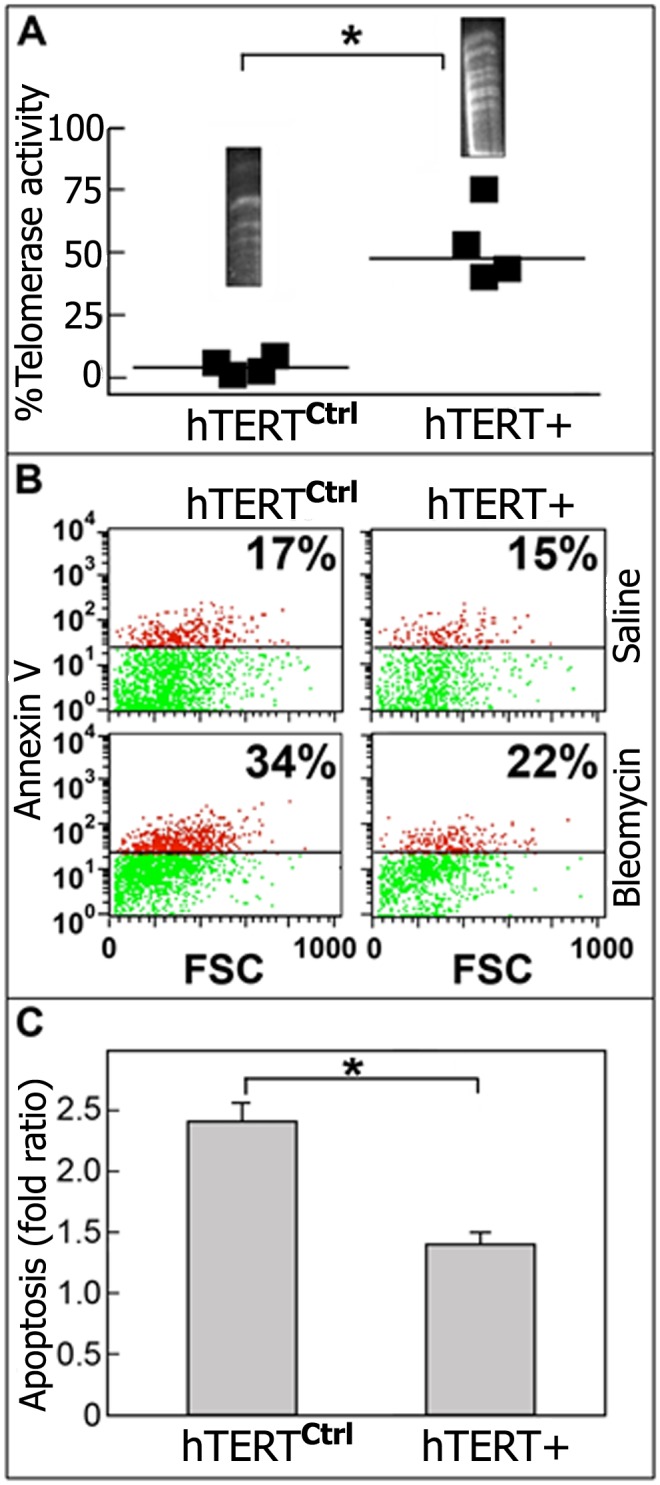
Decreased bleomycin-induced apoptosis in hTERT transfected MLE cells.(A) PCR-based telomerase activity in Mouse-Lung Epithelial (MLE) cells transfected with hTERT+ or control hTERT (hTERTctrl) expression vectors. hTERT+ and hTERTctrl MLE cells were exposed to bleomycin (0.06mU) or control saline. (B) Flow cytometry analysis demonstrating decreased Annexin V staining in bleomycin-treated hTERT+ compared to hTERTctrl cells. (C) Bar diagram representing the fold ratio (bleomycin/saline) of MLE cell apoptosis in hTERT+ vs. hTERTctrl MLE cells (n = 4, *p<0.05).